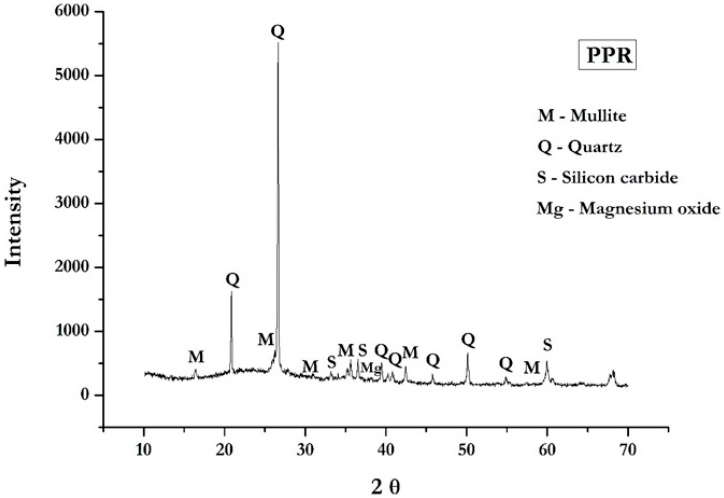
Figure 2. XRD pattern of the PPR used.